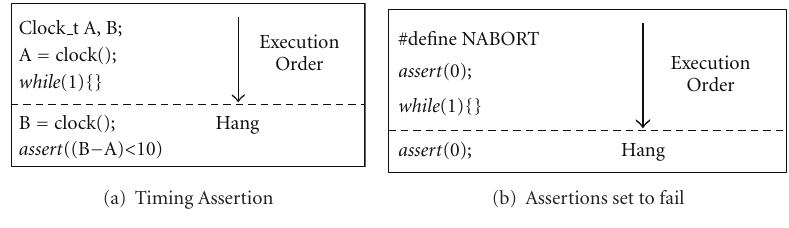
Figure 6: Manually using ANSI-C assertions for hang